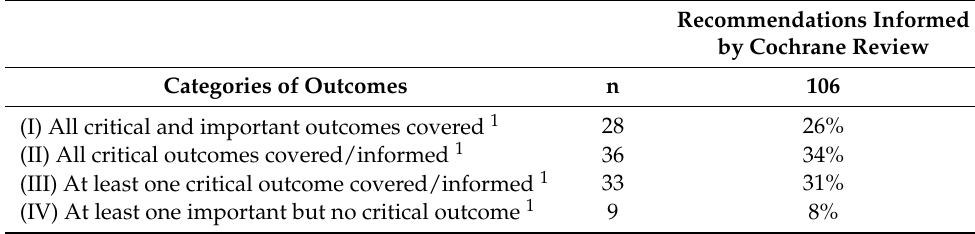
Table 2. Proportions of categories of outcomes informed by Cochrane reviews in Danish National Clinical Guideline development.